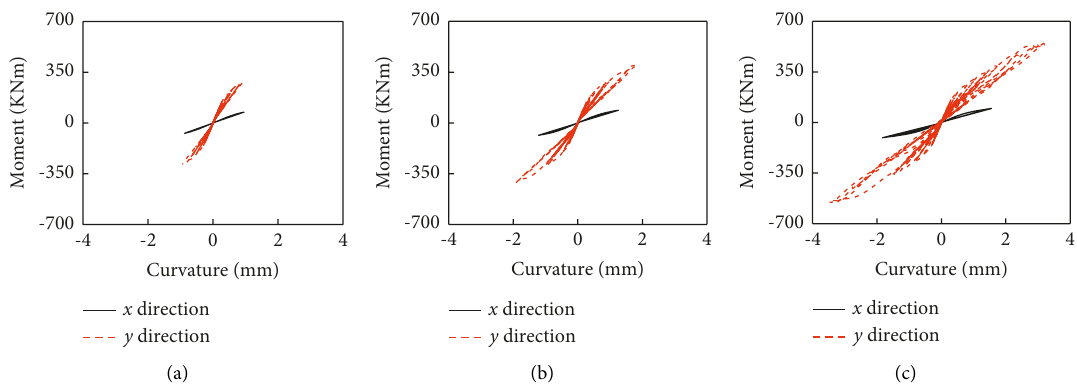
Figure 11: Sectional hysteresis behavior at the bottom of specimen under (a) 0.45 (g), (b) 0.60g, and (c) 0.96g PGA (average acceleration parameters: c